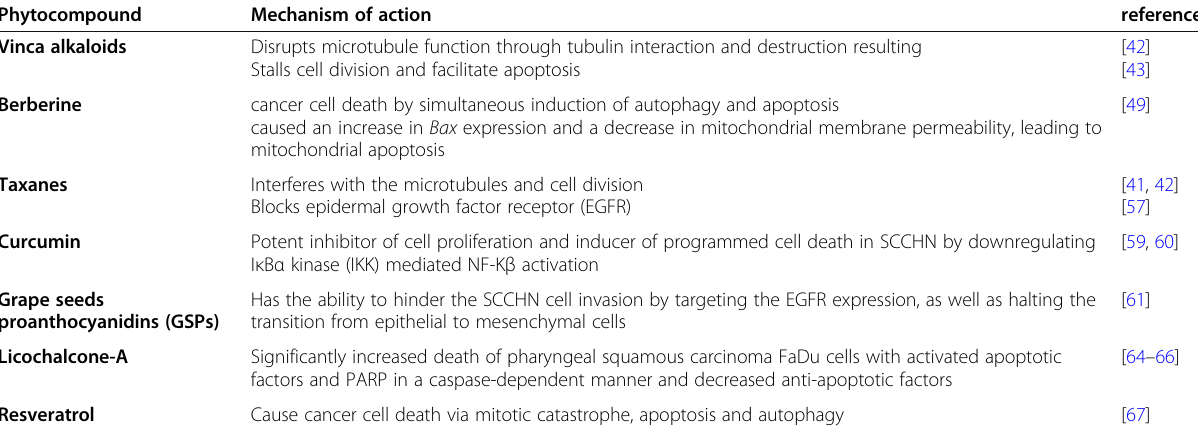
Table 1 Selected phytocompounds of therapeutic importance against head and neck cancer Phytocompound Mechanism of